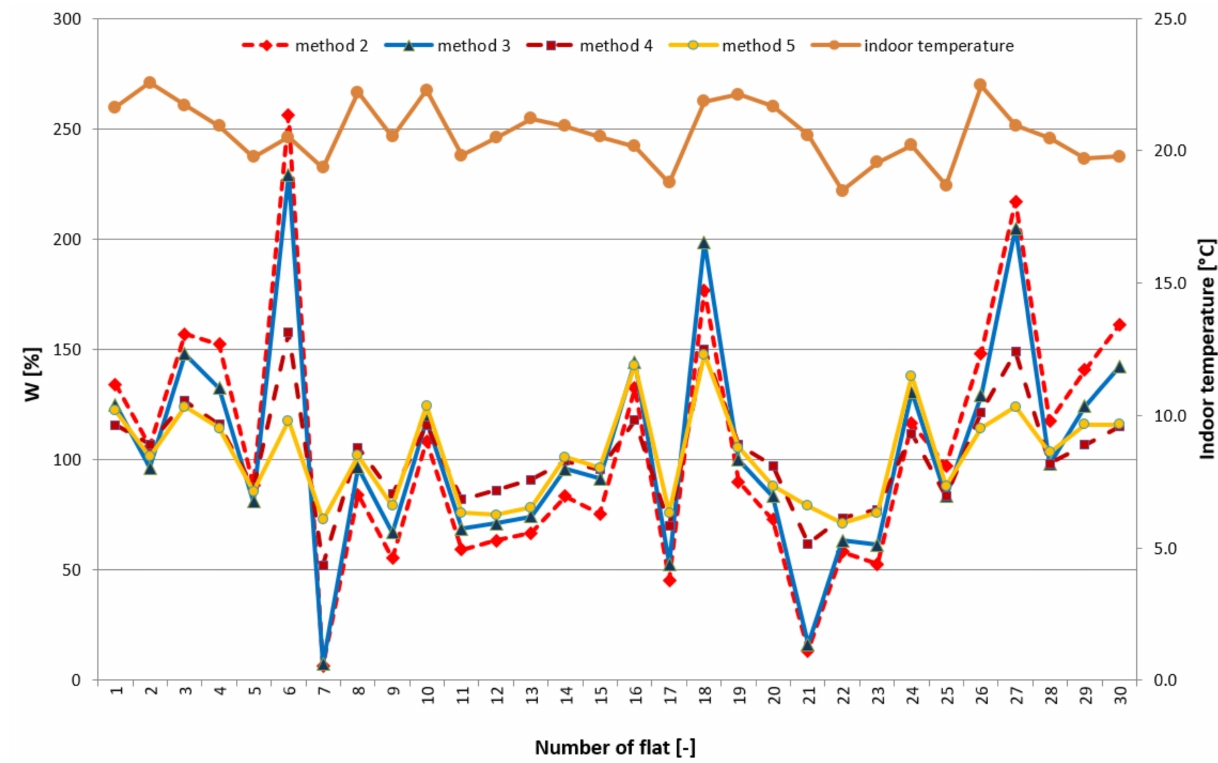
Figure 7. Percentage distribution of individual heat costs in relation to the average value of individual heat costs ( W ) for the analysed methods 2–5 of variable heat costs allocation and the plot of indoor temperature in the flats.